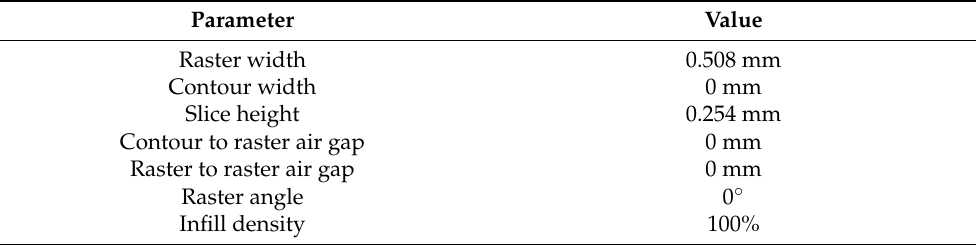
Table 1. Printing parameters.